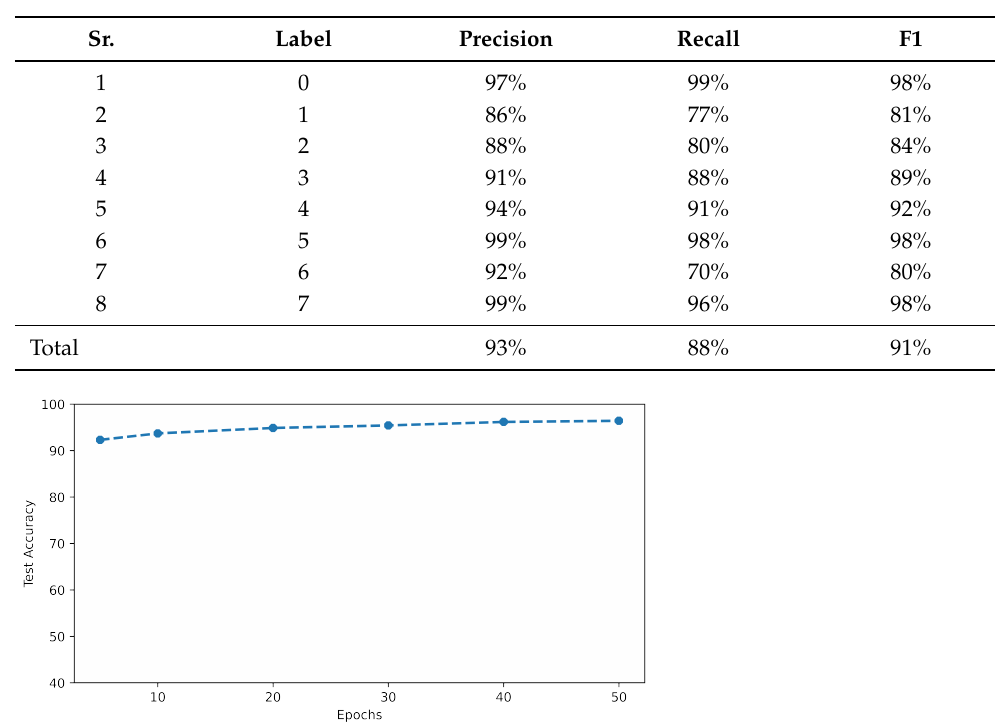
Figure 10. MLP learning and validation curves. Table 4. Intra-class summary of MLP performance on testing data.